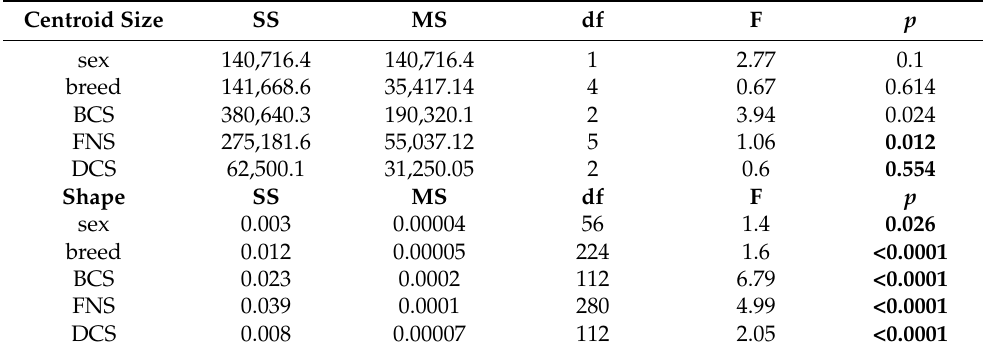
Table 1. The effect of classifiers (sex, breed, BCS, FNS, and DCS) on both the centroid size and shape of a donkey ’ s dorsal profile, determined using the Procrustes ANOVA by sums of squares (SS) and mean squares (MS). The significance level was established as p < 0.05. The significant effect of the classifier is marked in bold font in the p − value column. The bold is used here to separate the heading and the features/data.